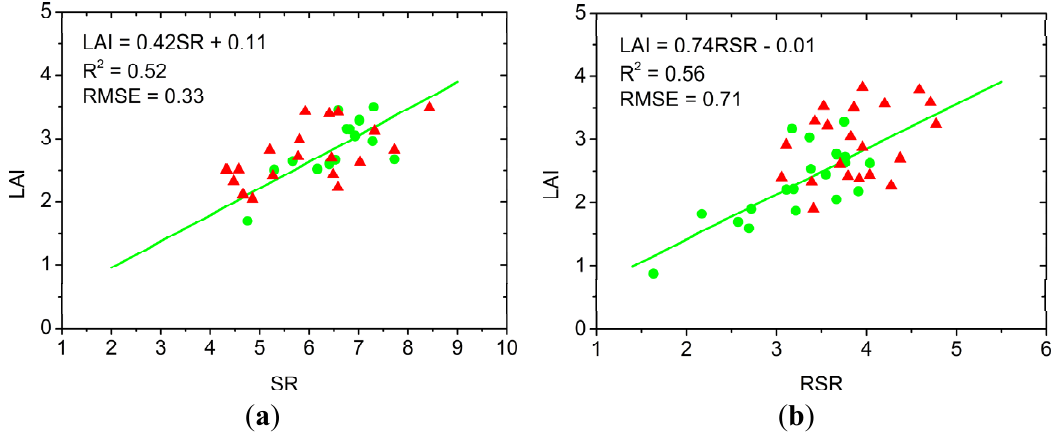
Figure 2. The regression lines between VI and LAI in AREA ( a ) and FEA ( b ). The dots indicate the measurements described in Section 3.2.1 and were used to fit the regression lines. The triangles indicate the independent validation samples collected in different field campaigns in the same study